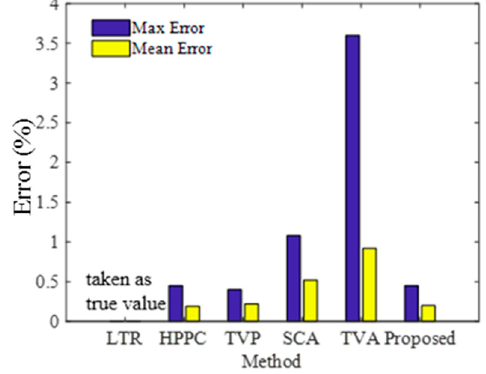
Figure 12. Estimation errors of different methods.